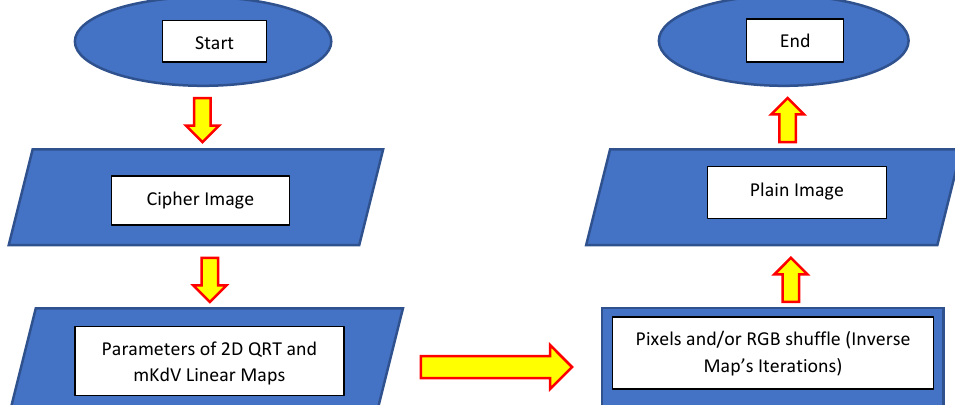
Figure 3. A flow chart for the proposed decryption 410 | Vol. 7, No. 3, 2022